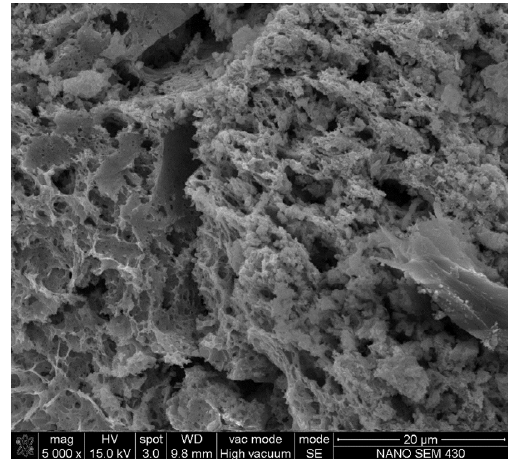
Fig. 5 SEM micrograph of SmAlO 3 powders calcined at 750 ℃ for 2 h without grinding.